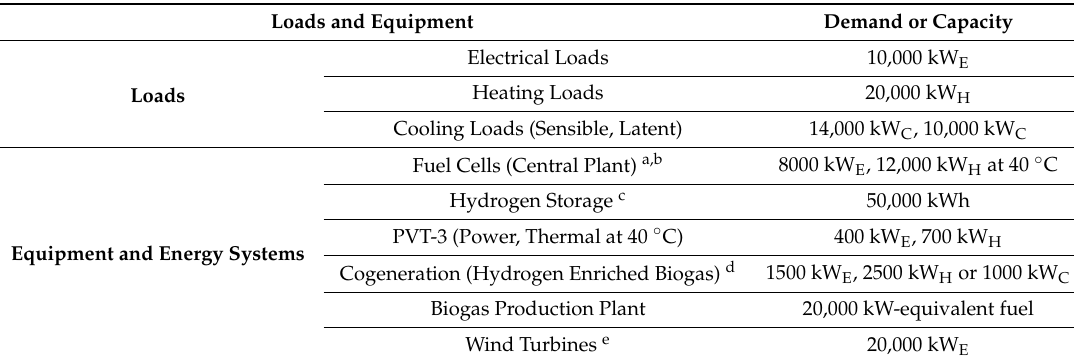
Table 6. Power and Thermal Loads for the District